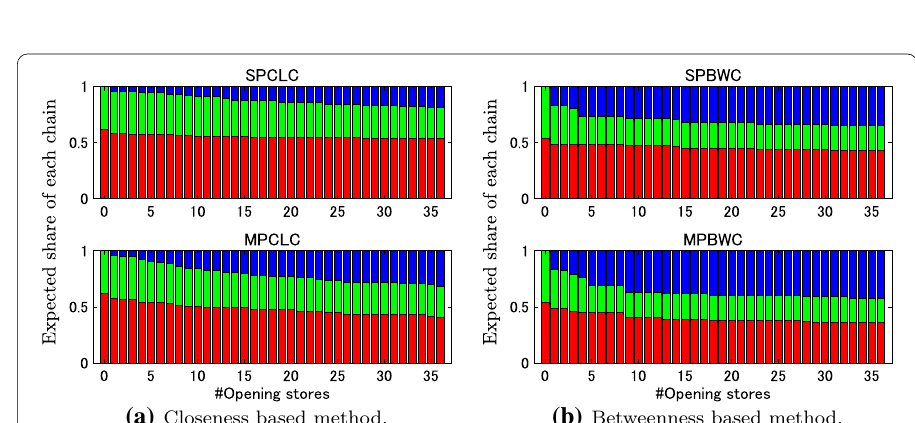
Fig. 8 Expected share of each group after opening stores of g3 and their breakdown (Hachioji): Each bar shows the expected number of covered nodes and their breakdown (g1: red, g2: green, and g3: blue) when stores of the g3 group are opened one by one at the nodes extracted by each